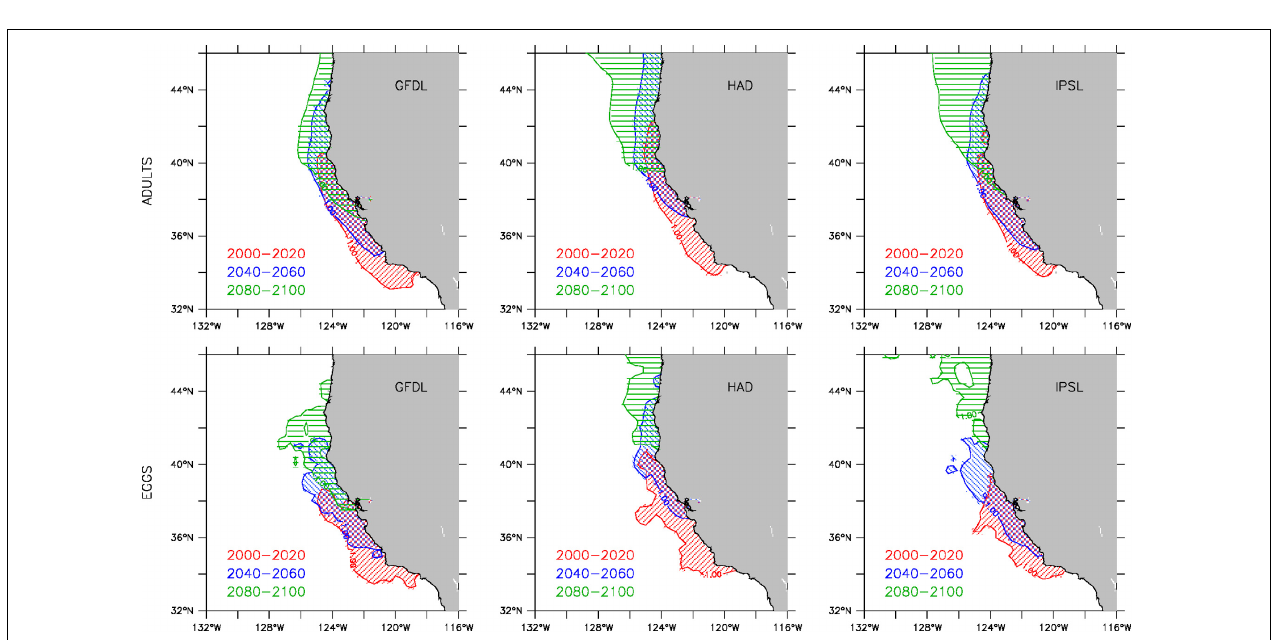
FIGURE 3 | Projected sardine spawning stock biomass (10 3 metric tons) for 2000–2100. The time series represent CCS-wide annual adult (age-2 and older) biomass from the ensemble mean (black) and individual GFDL (red), Hadley (green) and IPSL (blue) solutions (gray shading denotes ensemble spread). Insets represent the ensemble mean spatial biomass distribution (metric tons per km 2 ) for 2000–2020 (left) , 2040–2060 (center) , and 2080–2100 (right) .